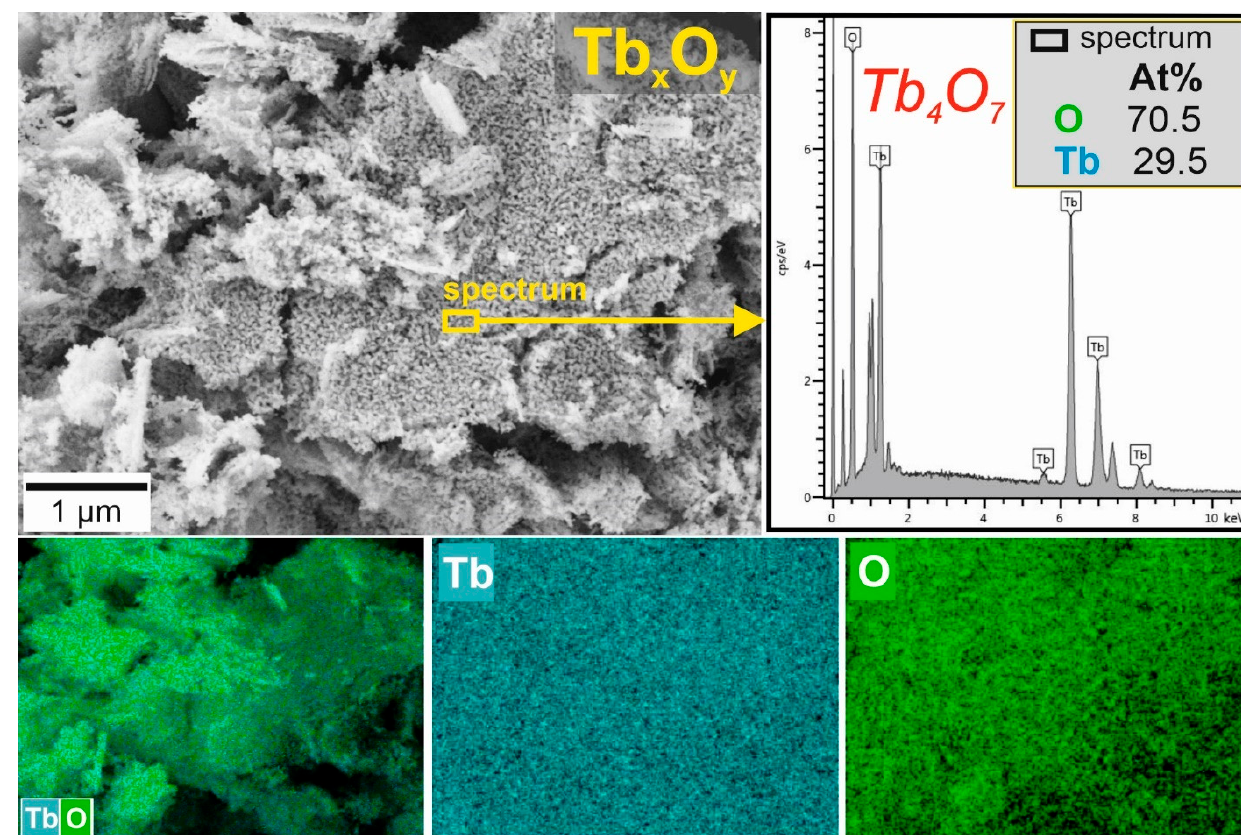
Figure 6. SEM surface morphology images of Tb x O y powder and EDS elemental mapping.